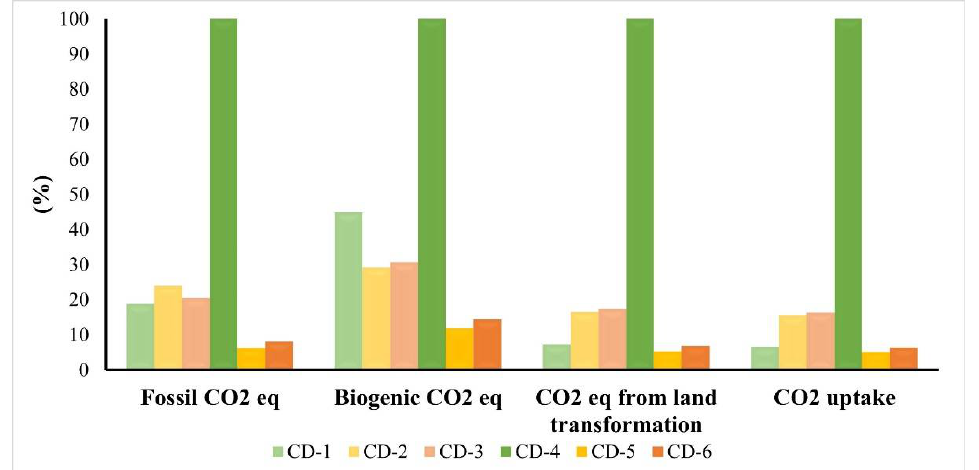
Figure 6. Relative environmental impacts of syntheses under study for incineration disposal scenario, applying Greenhouse Gas Protocol method. Green scale refers to hydrothermal treatments; Yellow scale refers to microwave-assisted treatments; Orange scale refers to calcination treatments.